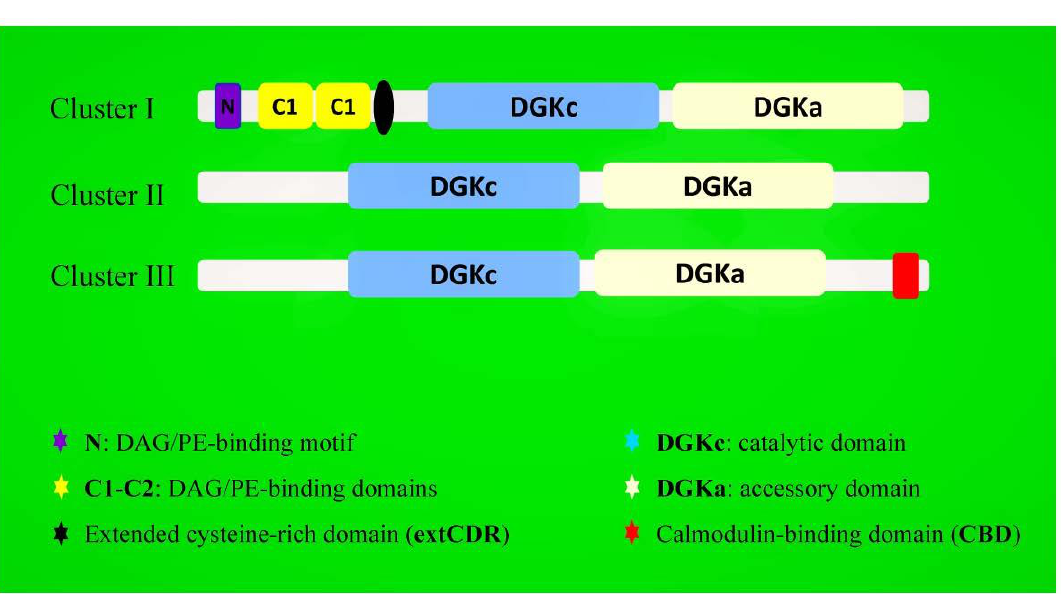
Figure 2. A generalized representation of plant DGK protein-conserved domains in a different cluster. The purple box represents an upstream basic region, the yellow boxes, two DAG-binding domains (C1 and C2), black box, an extended cysteine-rich domain (extCRD), the diacylglycerol kinase accessory domain (DGKa) by the cream colored boxes, the diacylglycerol kinase catalytic domain (DGKc) by a blue box, and calmodulin-binding domain (CBD) by the red box.